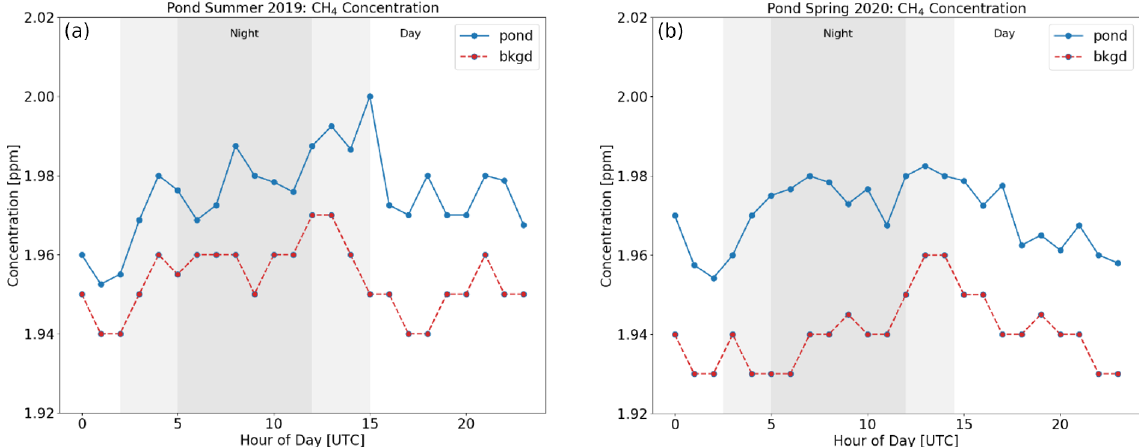
Figure 6. Tailings pond and background CH 4 median hour-of-day concentration for summer 2019 (a) and spring 2020 (b)